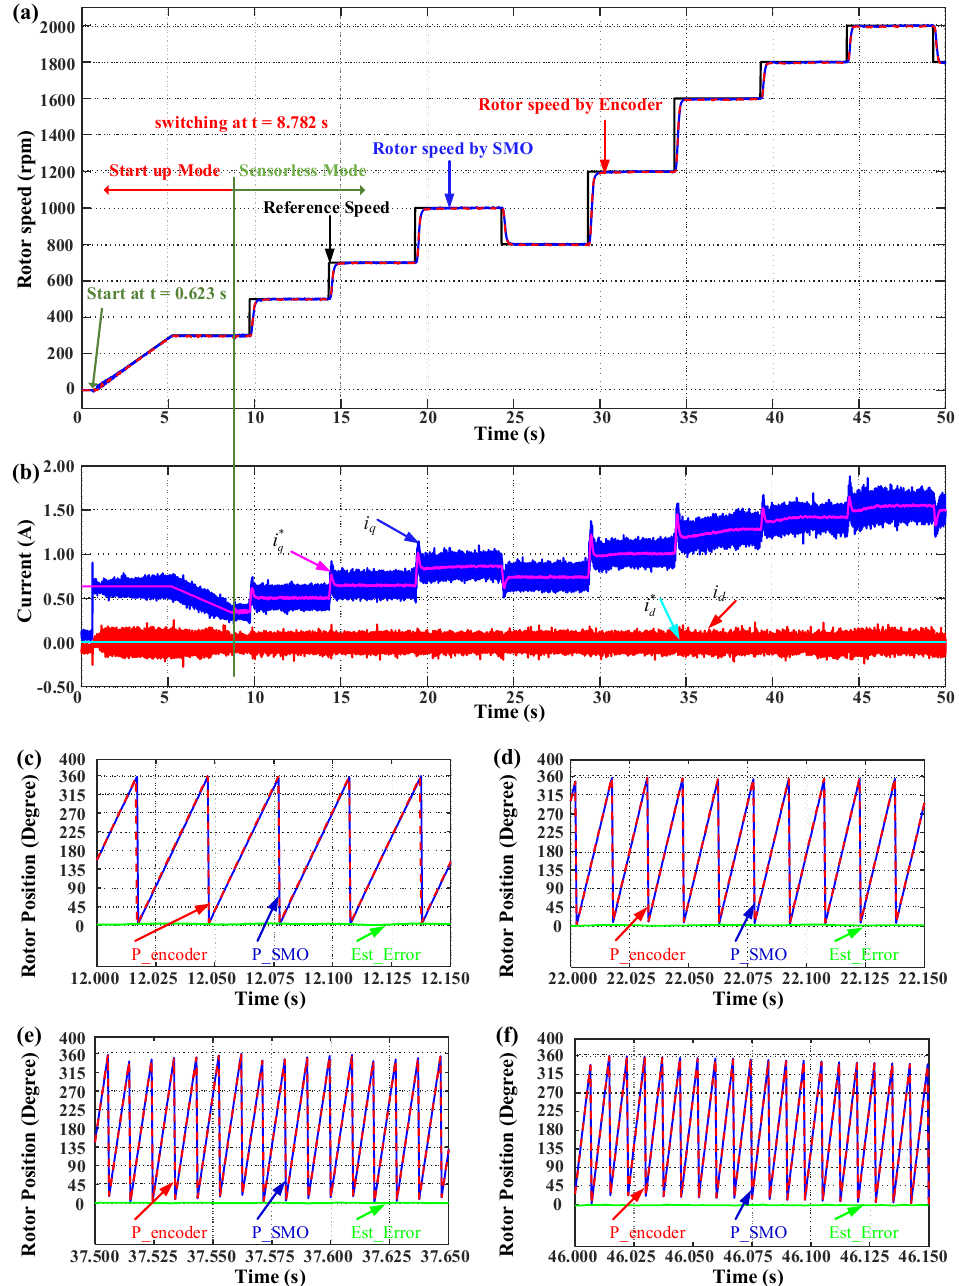
Figure 13. Experimental results in the speed increasing strategy, from 0 to 2000 rpm for ( a ) speed response, ( b ) current response, and rotor position response at ( c ) 500, ( d ) 1000, ( e ) 1600, ( f ) 2000 rpm.